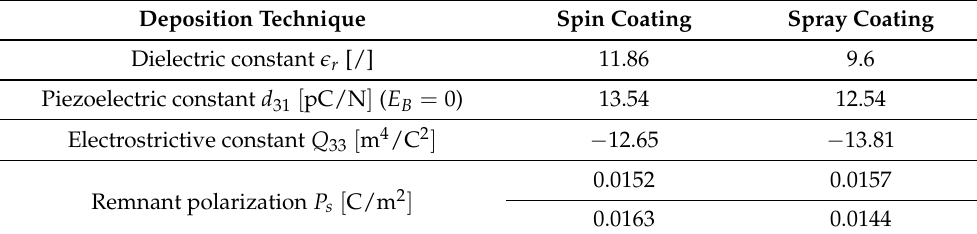
Table 1. Estimation on material parameters (PVDF-TrFE)